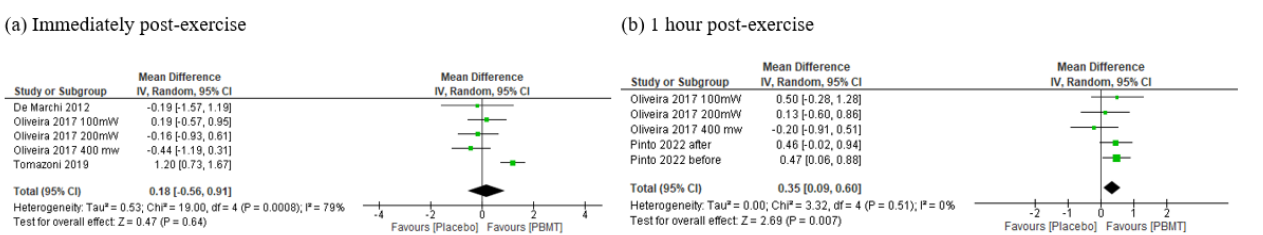
Figure 2. Meta-analysis of SOD activity immediately ( a ), 1 h ( b ), 24 h ( c ), 48 h ( d ), 72 h ( e ) and 96 h ( f ) post exercise. PBMT — photobiomodulation, IV — inverse variance, CI — confidence interval.